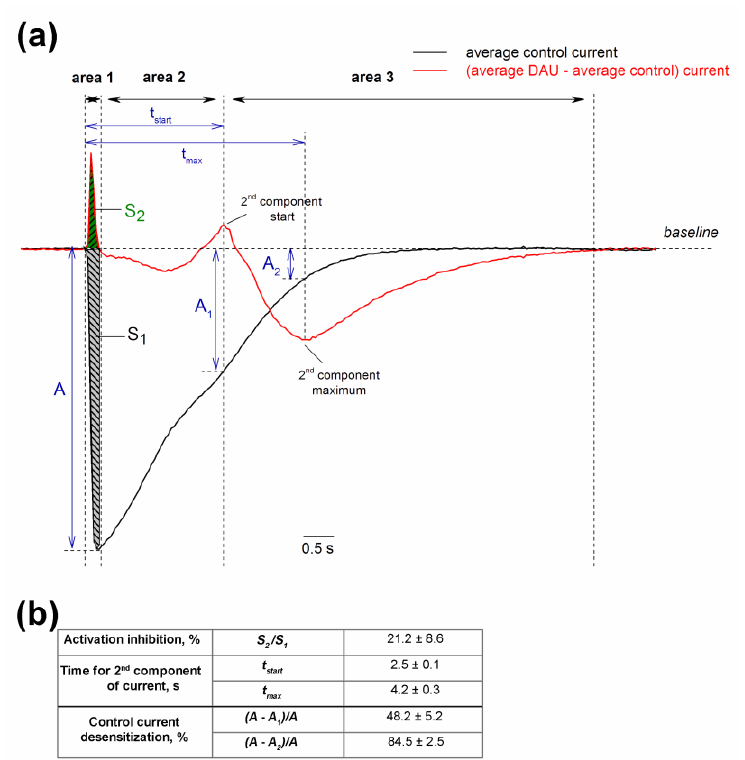
Figure 8. Dual e ff ect of pre-incubated DAU on ASIC1a channel. ( a ) Average control current (n = 7; black trace) and current obtained by subtracting the average control current from the average current induced by 300 µ M DAU (n = 7; red trace). The black arrows indicate the boundary of the three conditional zones of the DAU action: Area 1 (inhibitory), area 2 (neutral), and area 3 (potentiating). For area 1, we calculated the integral control current S 1 (grey) and the integral inhibited current S 2 (green). A is the maximal amplitude of the control current; A 1 and A 2 are the amplitudes of the control current at time t start (the start of second peak’s development) and t max (the second peak’s maximum), respectively. ( b ) Calculated parameters of the DAU e ff ect, presented as mean ± SEM (n = 7). The inhibition of the channel activation as a ratio of area S 2 to area S 1 is expressed as a delay in the of channel’s opening kinetics without a change in the peak amplitude (A). We estimated the percentage by which the main current is desensitized at t start and t max using the ratio of the di ff erence between amplitudes (A minus A 1 and A 2 , respectively) to amplitude A.